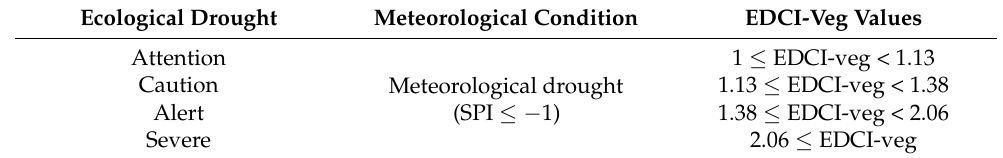
Table 1. Ecological drought stage classification of vegetation by EDCI-veg. Ecological